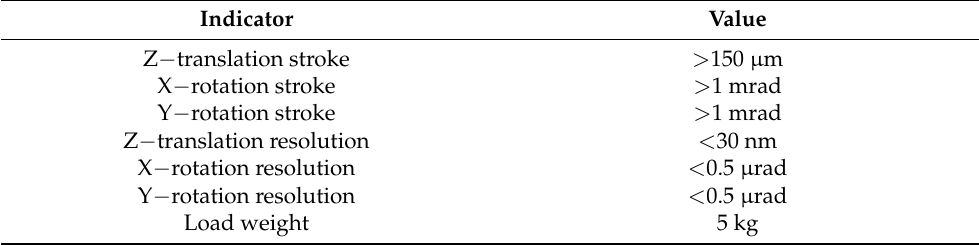
Figure 1. The active optical system with three spherical mirrors. Table 1. The indicators designed for the piezoelectric positioning platform.